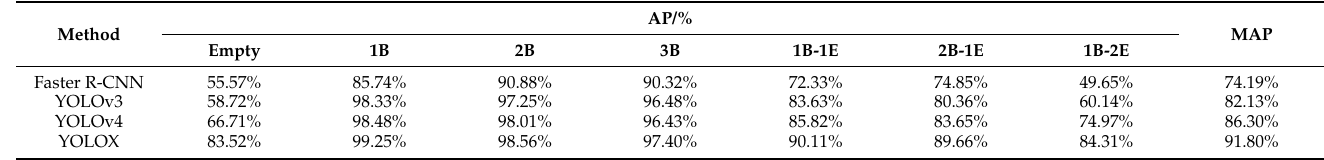
Table 7. Average accuracy versus average accuracy of pod category detection for different models in the test dataset HPD.